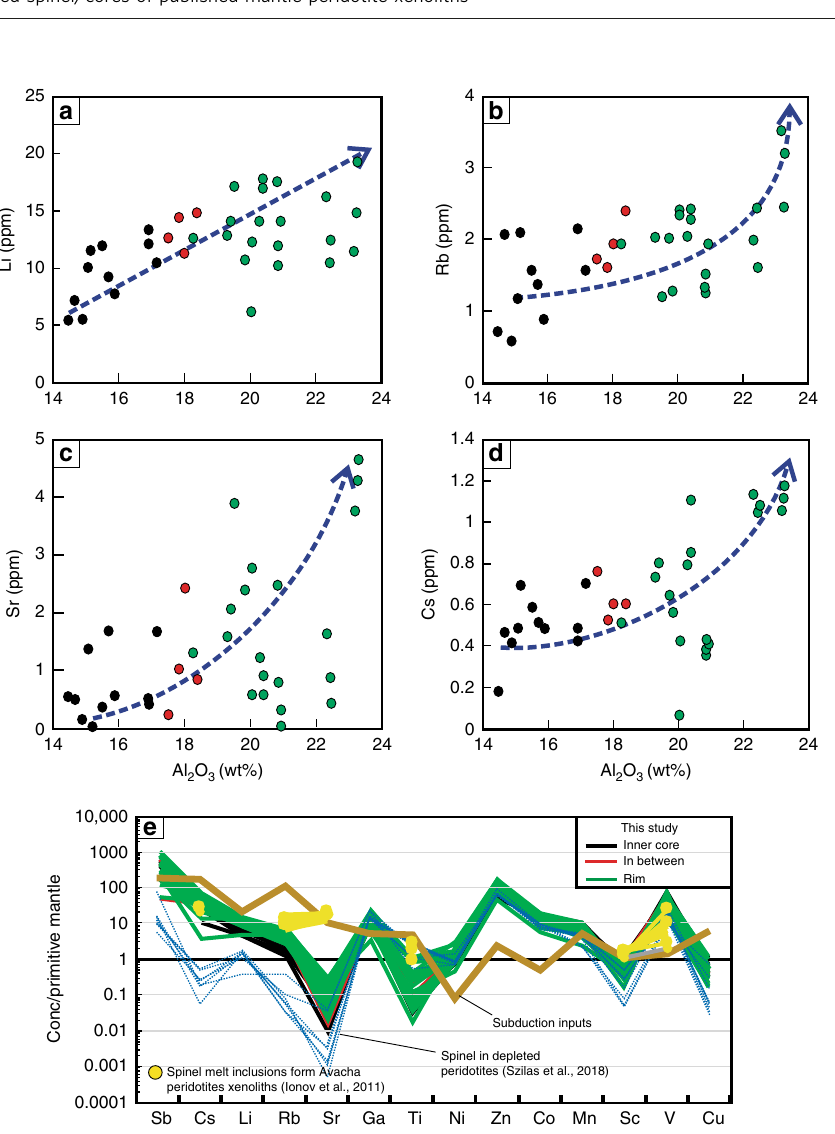
Fig. 2 Plots of the studied Cr-Spinel chemical composition for different zones within the grains. a Cr# (Cr/Cr + Al) vs. Mg# (Mg/Mg + Fe + 2 ) plot of all the raw datasets for Cr-spinel grains in the studied rocks. Such data are usually not published in previous literature. The data span between recommended fi elds used in previous literature for abyssal peridotites 4 and fore arc (FA)-peridotites 40,42 . b Representative/average Cr-spinel data for each sample. Such sample-average data are usually used in previous mantle petrology studies. This plot shows that our samples had a fore arc to abyssal peridotite origin. c Al 2 O 3 vs Cr 2 O 3 and d Cr# vs Mg# plots of the studied Cr-spinel grains with low Al 2 O 3 and high Cr 2 O 3 and Cr# in their cores, and high Al 2 O 3 and Low Cr 2 O 3 and Cr# in their rims (reverse zoning). Partial melting trend and the brown line between abyssal peridotites (Cr# < 0.60) and FA-peridotites (Cr# > 0.60) are from Dick and Bullen 4 . e All datasets have trends parallel to both the melting trend and our newly de fi ned metasomatism trend. f Datasets of different zones (from core to rim) from four grains from a single sample (sample # A4D) that show large Al-Cr heterogeneity. The data span across the whole range between abyssal peridotites and FA- peridotites. g Plots of the studied Cr-spinel grains compared with the compositions of both modi fi ed spinel/rims and non-modi fi ed spinel/cores of published mantle peridotite xenoliths 17,18,34,39